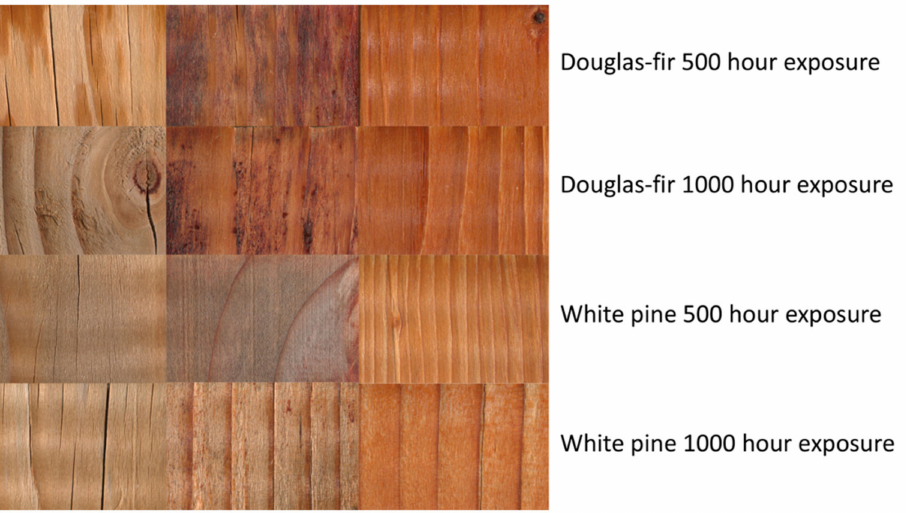
Figure 2. Weathered samples. ( Left ) column: controls; ( Center ) column: red aniline stain and finish treatment; ( Right ) column: red fugal pigmented